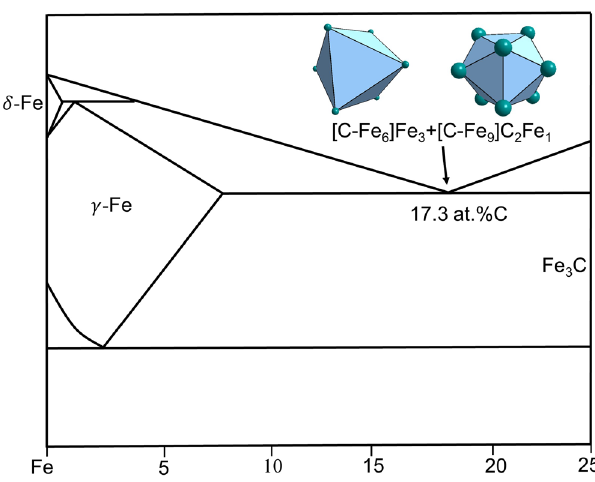
Figure 7. Interpretation of Fe 82.7 C 17.3 eutectic point by the dual-cluster formula [C-Fe 6 ]Fe 3 + [C-Fe 9 ]C 2 Fe from eutectic phases γ -Fe(C) and Fe 3